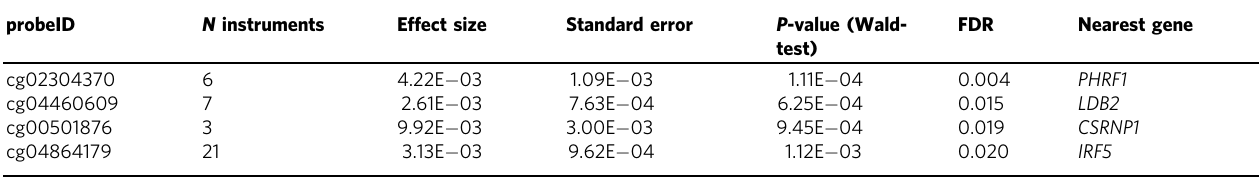
Table 3 CpG sites having a potentially causal effect on eGFR as assessed by Mendelian